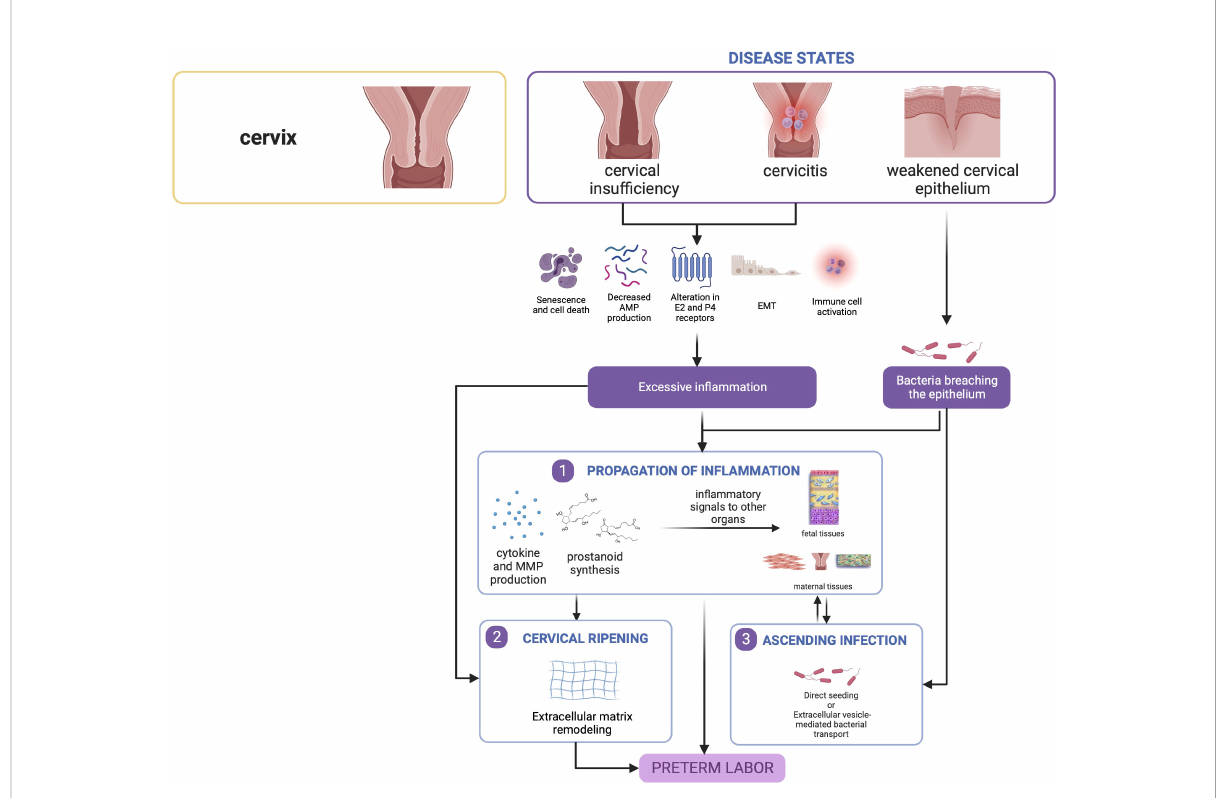
FIGURE 5 Disease states in the cervix contribute to preterm birth. Cervical insuf fi ciency and cervicitis may lead to localized in fl ammatory responses that can propagate towards other tissues. Similarly, a weakened epithelium may allow passage of bacteria leading to ascending infection, which also causes in fl ammation in seeded gestational tissues. This fi gure was created with